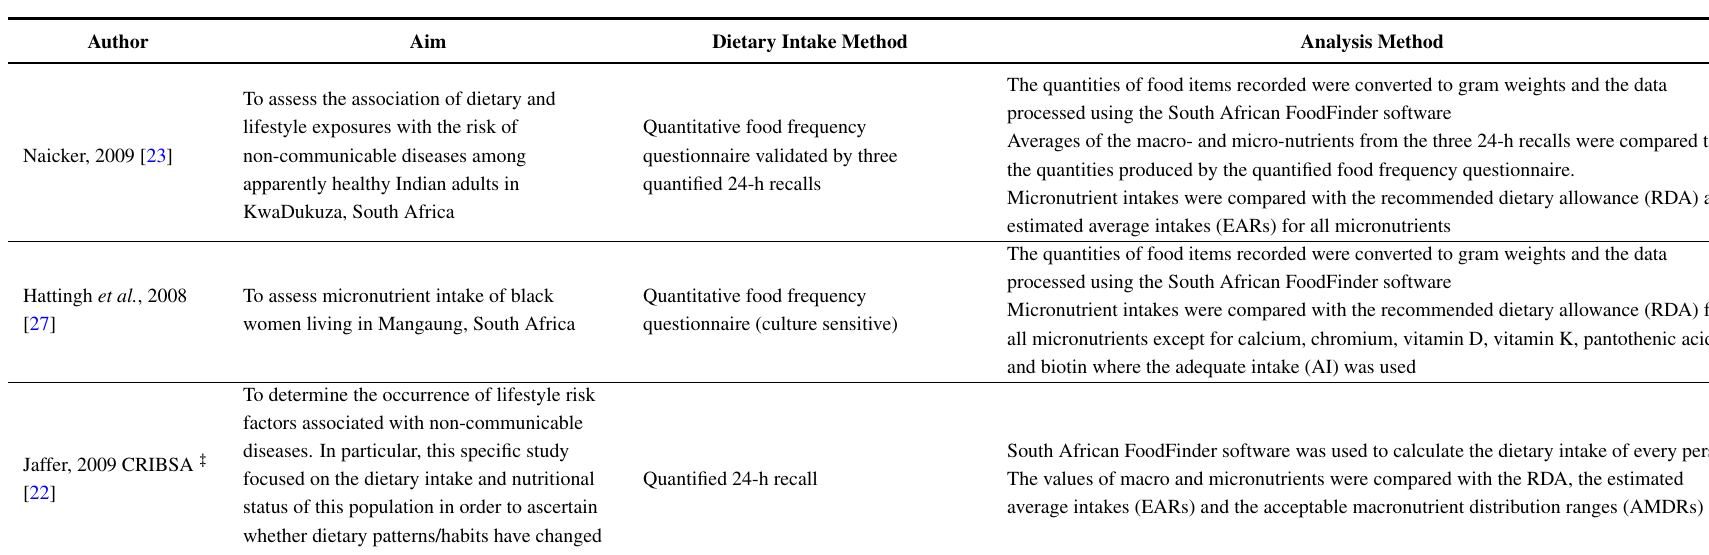
Table 2. Research methodology used in the reviewed